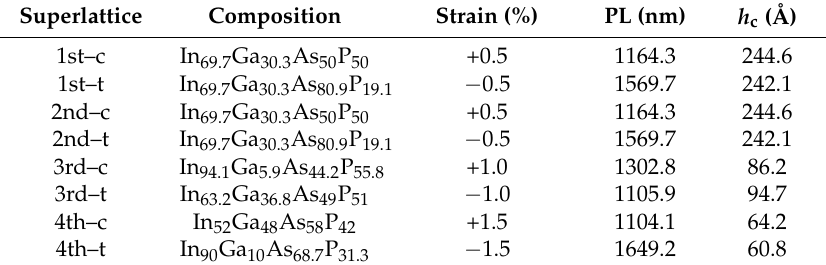
Table 1. Summary of the parameters of the superlattices used in this study.